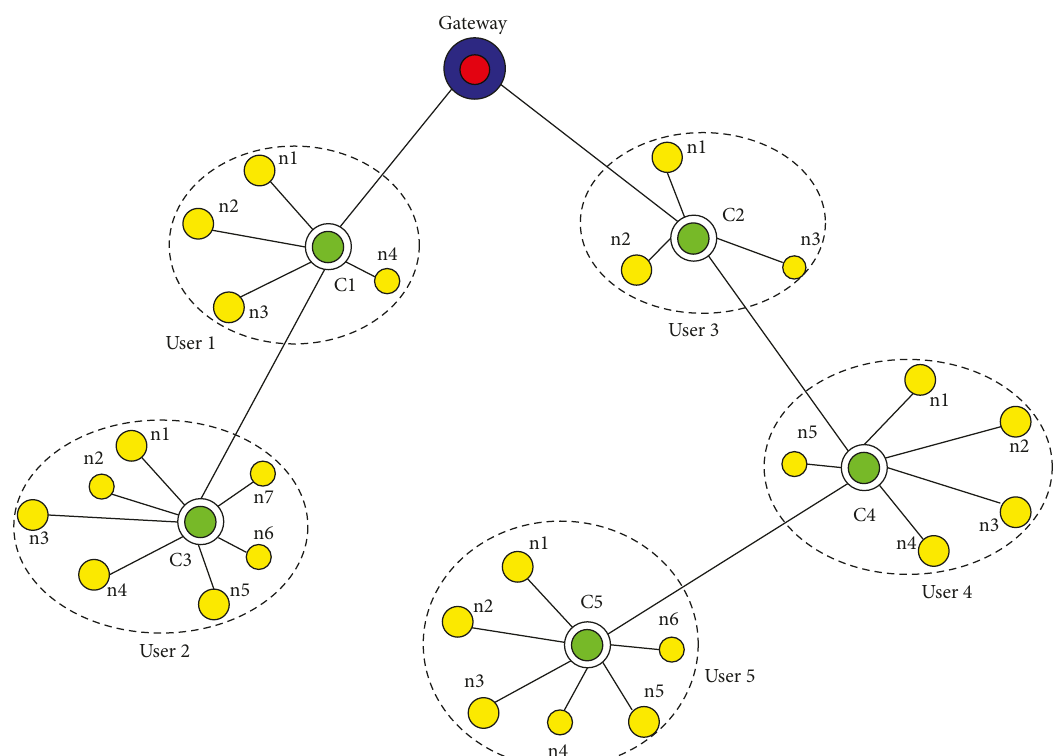
Figure 3: The communication topology of IoT healthcare systems: an illustration.